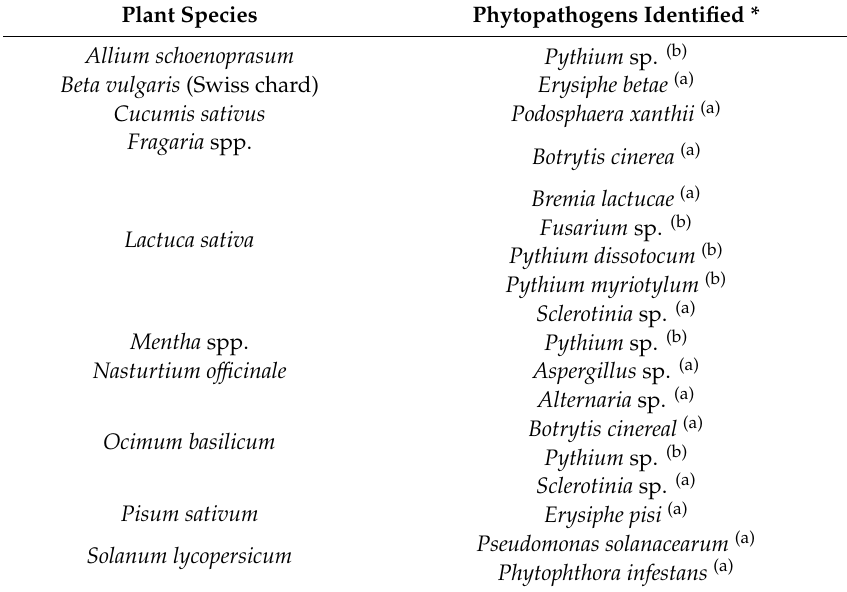
Table 1. Common phytopathogens summarized from 2018 international survey analysis in aquaponics systems and existing literature.